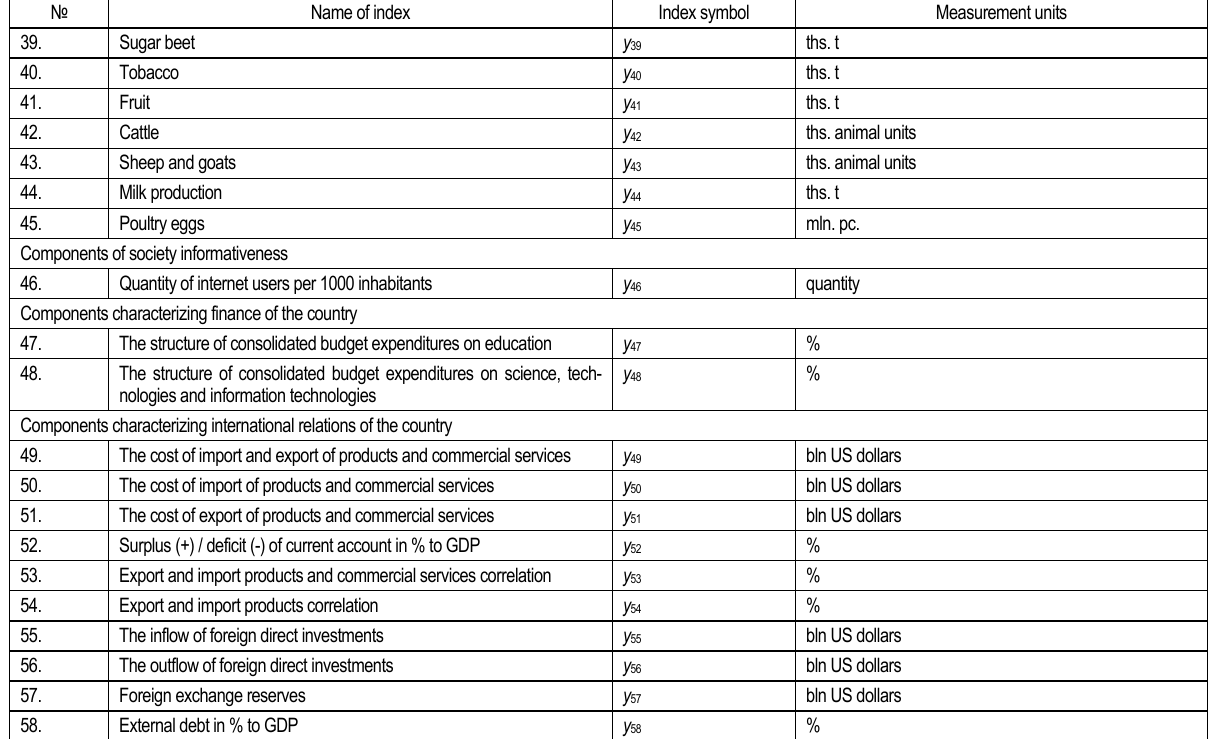
Table 1 (cont.). The list of indexes characterizing socioeconomic state of countries in terms of integration pro-